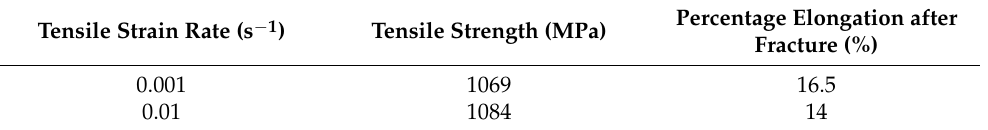
Table 5. Smooth experimental sample tensile